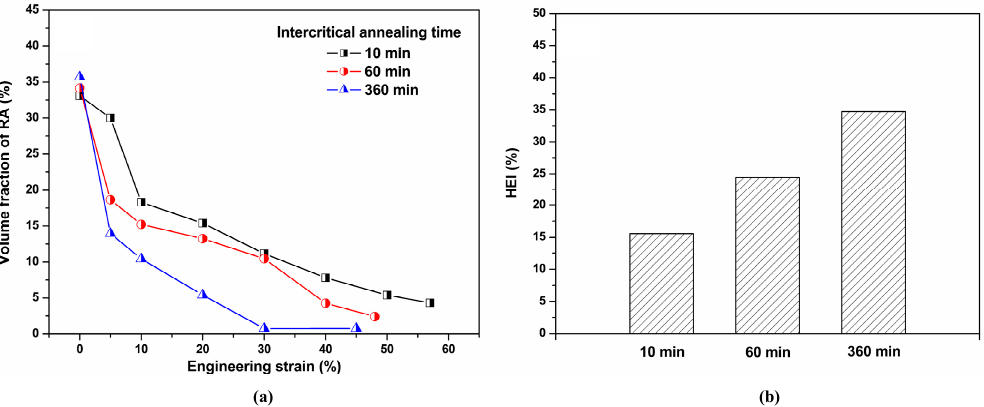
Figure 7. ( a ) Variations in the volume fraction of retained austenite in a medium-Mn steel (Fe–0.2C–5.0Mn–0.6Si–3Al, in wt pct) as a function of engineering strain and hold time (10–360 min) at an IA temperature of 750 °C. ( b ) HE index (relative elongation loss due to H) evaluated by SSRT testing as a function of IA time. Reproduced from Reference [44], with permission from Elsevier.